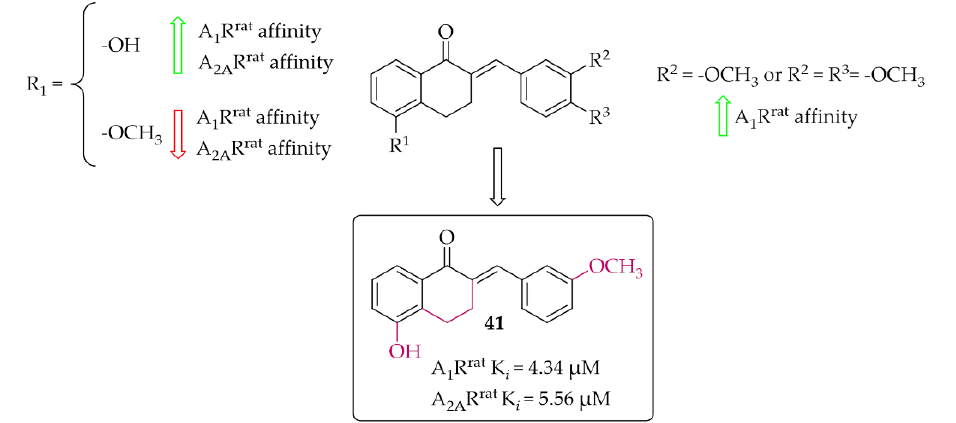
Figure 31. Tetralone-based chalcones and the most potent compound in the series [69].